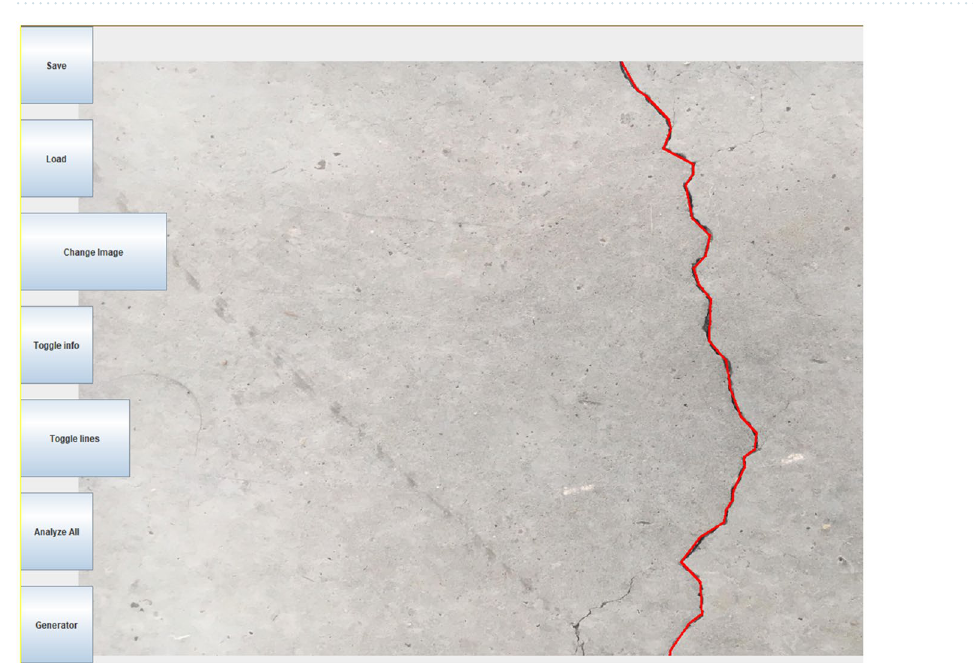
Figure 6. Tracing/analysis software